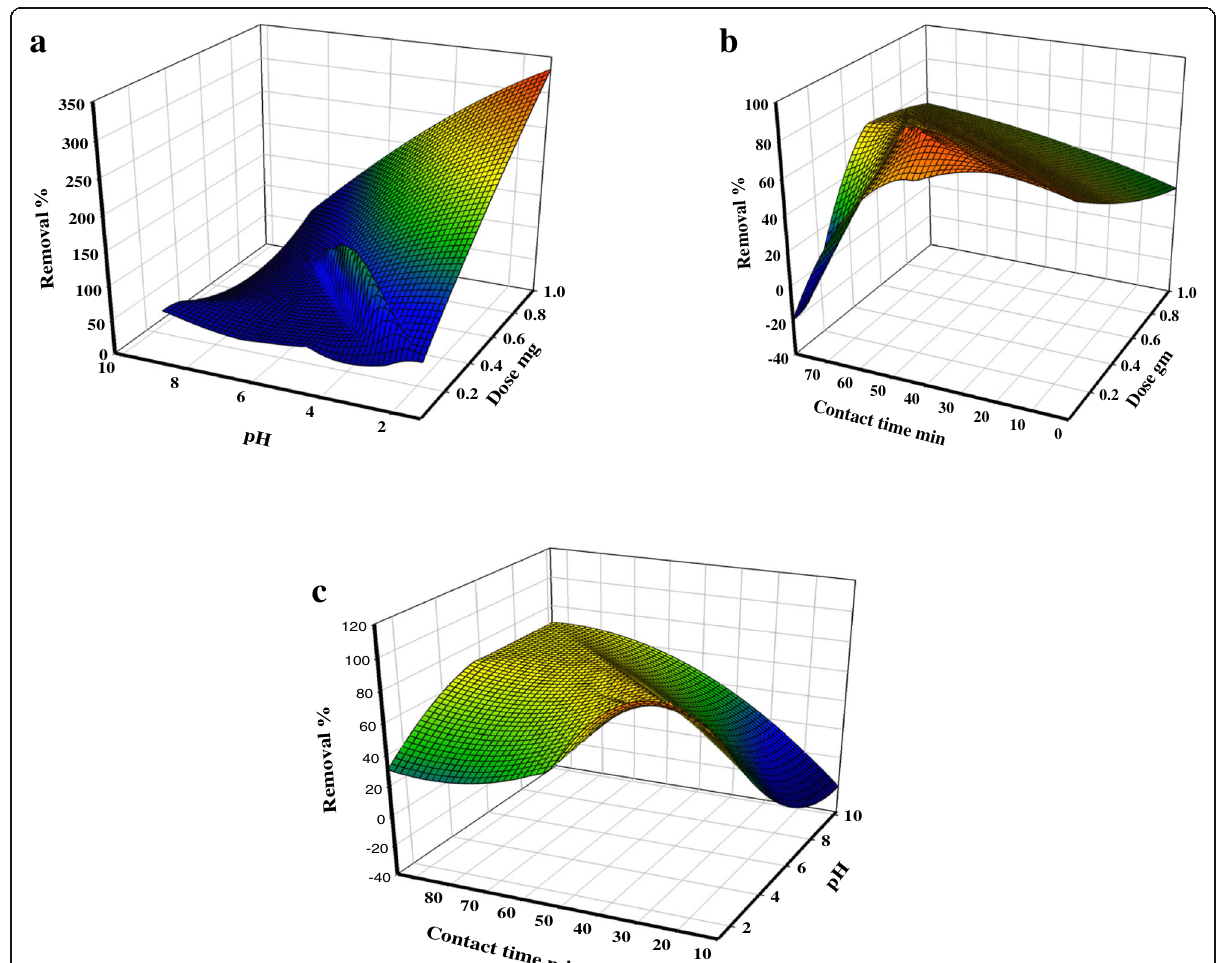
Fig. 9 3D graphs showing the effect of different variables on adsorption percent of AO67 on